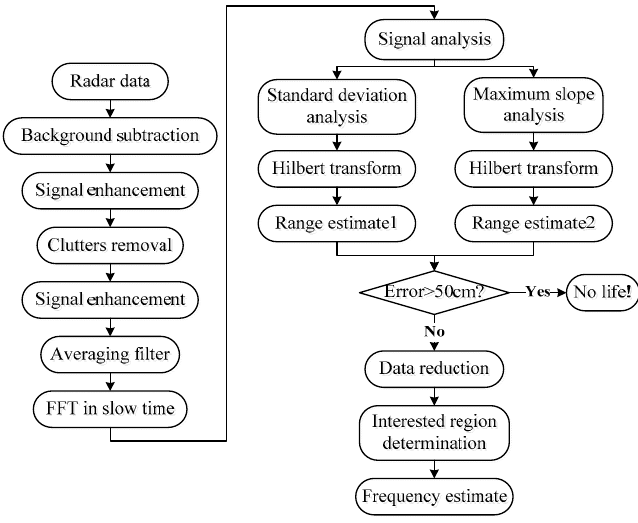
Figure 5. Flowchart of the developed human being detection method.